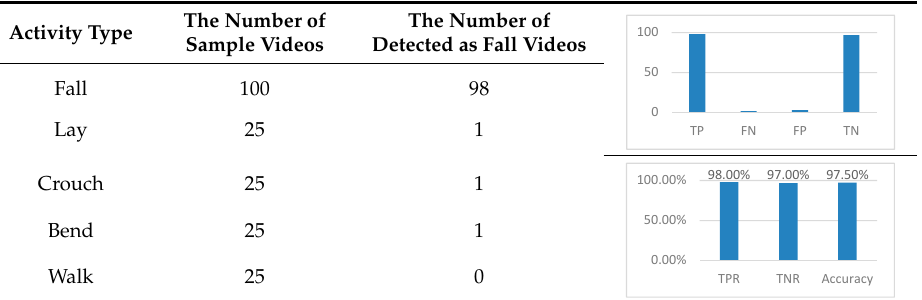
Figure 13. The time consumptions of each frame in walk and fall. The two test videos of this graph were selected randomly from the self-collected dataset. Table 2. Experimental results and evaluation of our approach.